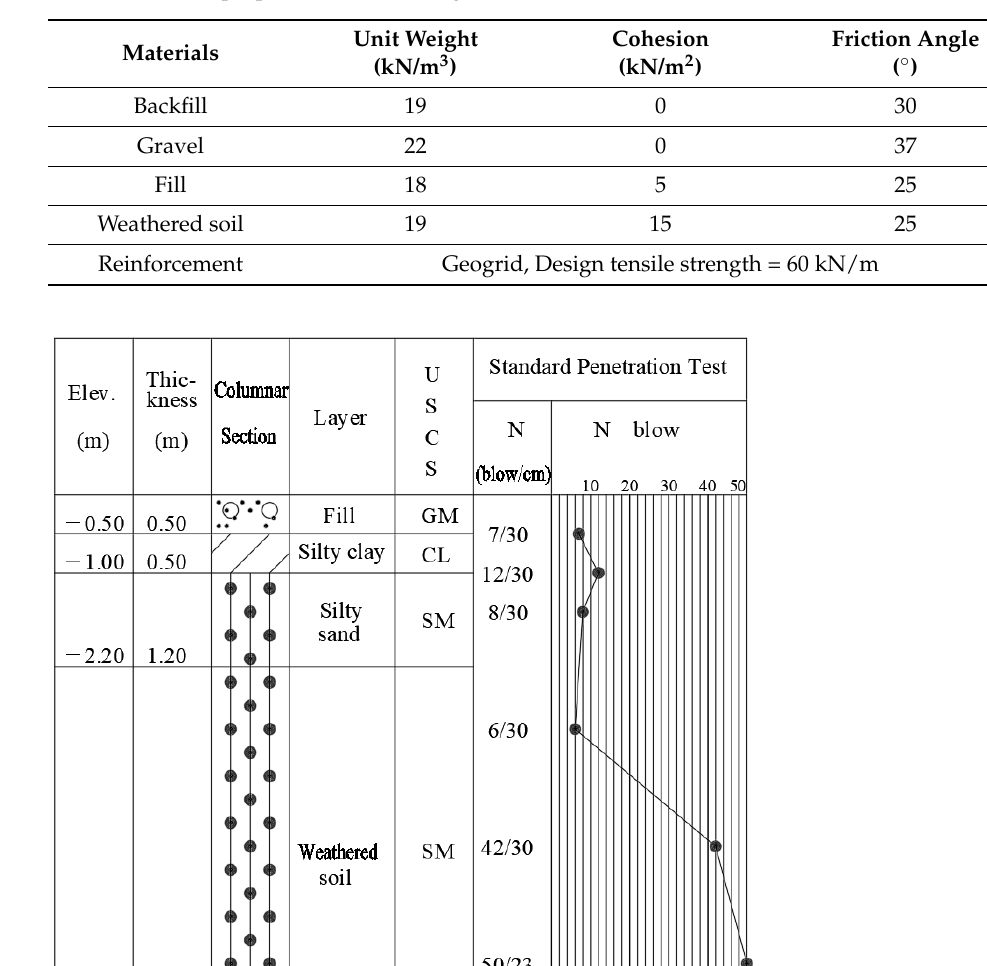
Table 3. Material properties for RSR design.